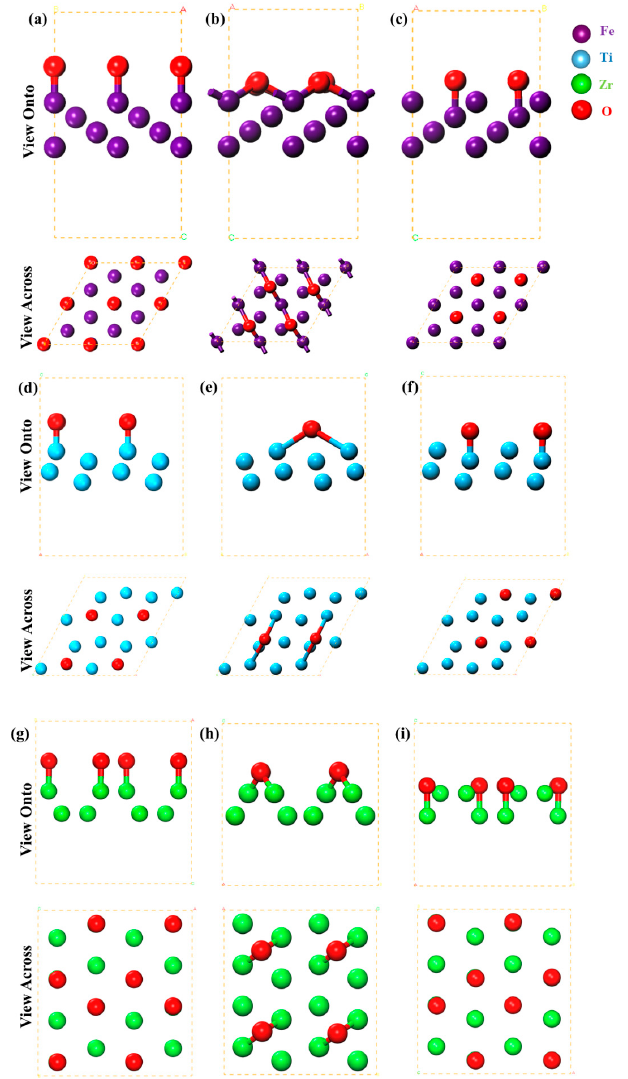
Figure 4. O was adsorbed in the top site ( a ), bridge site ( b ), and hollow site ( c ) of Fe(111); top site ( d ), bridge site ( e ), and hollow site ( f ) of Ti(111); top site ( g ), bridge site ( h ), and hollow site ( i ) of Zr(110).